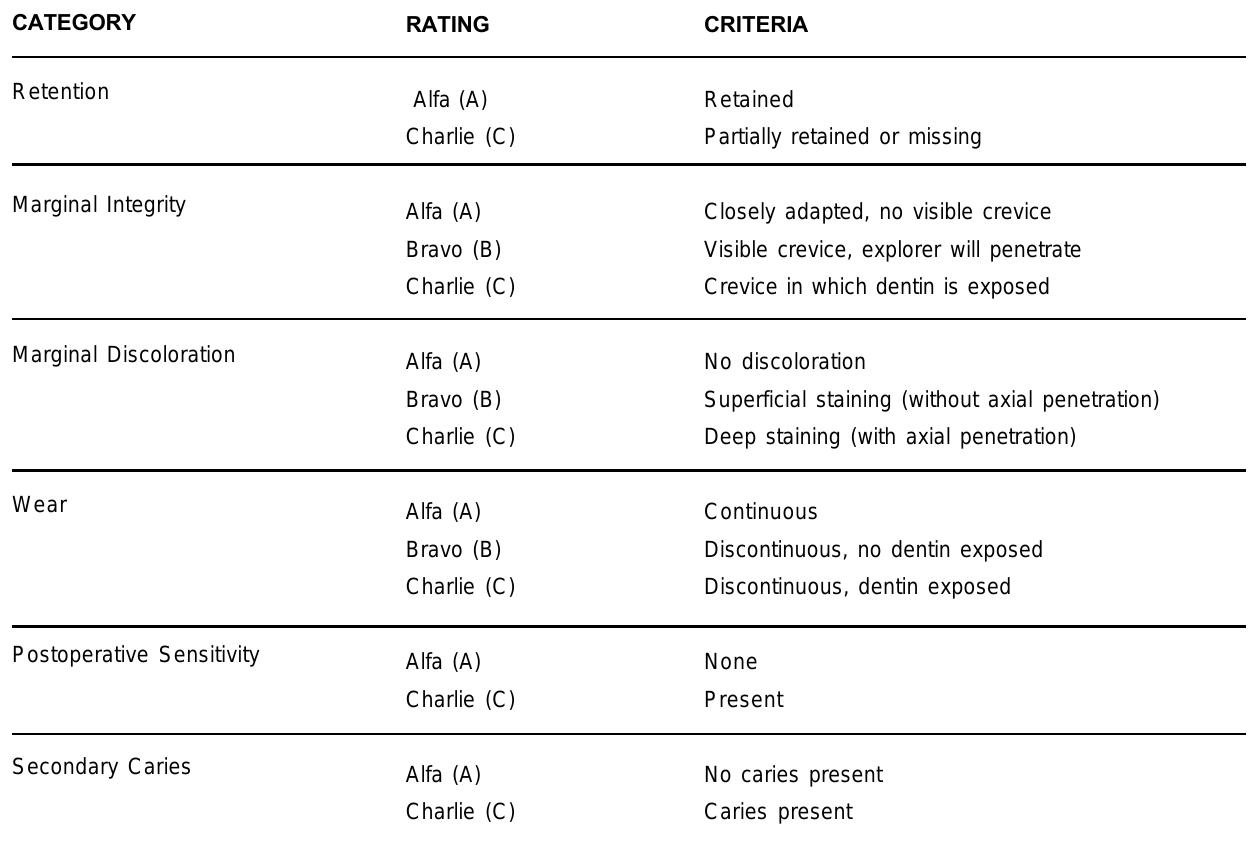
TABLE 1- Modified-USPHS rating criteria